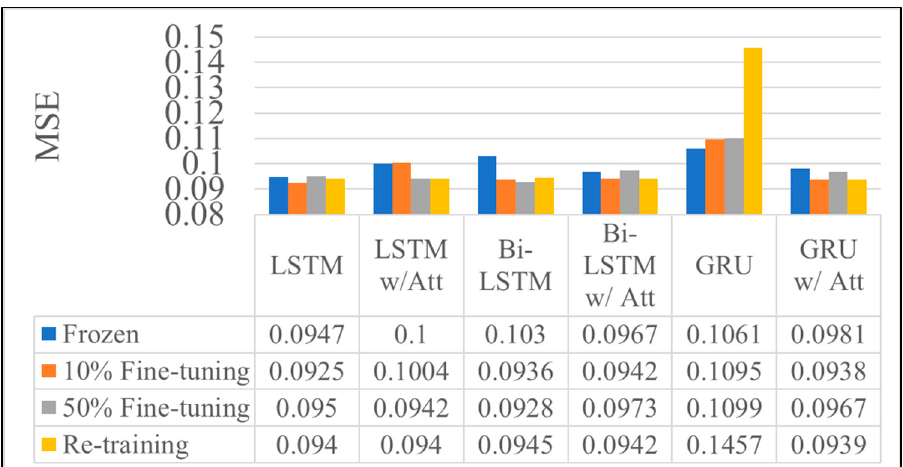
Figure 16. MSE of the target disease course prediction of TL-CDC without attention mechanism under k = 3.